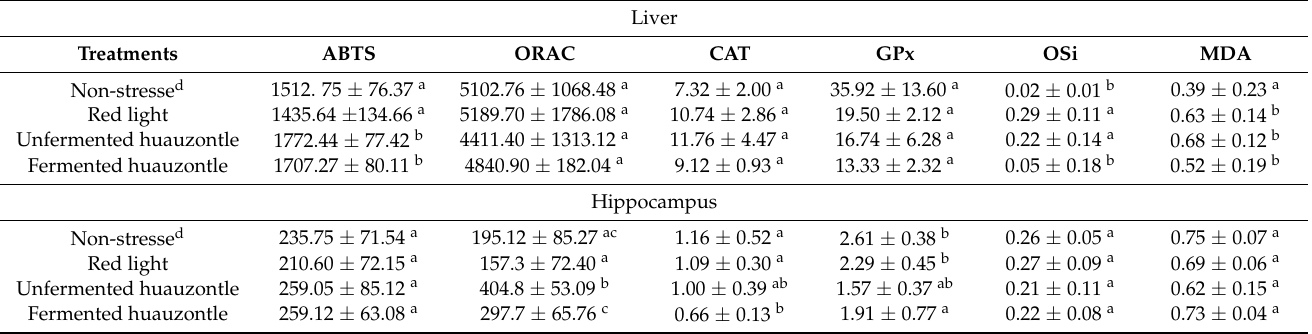
Table 1. Antioxidant status evaluated in liver and hippocampus samples at the different study groups.